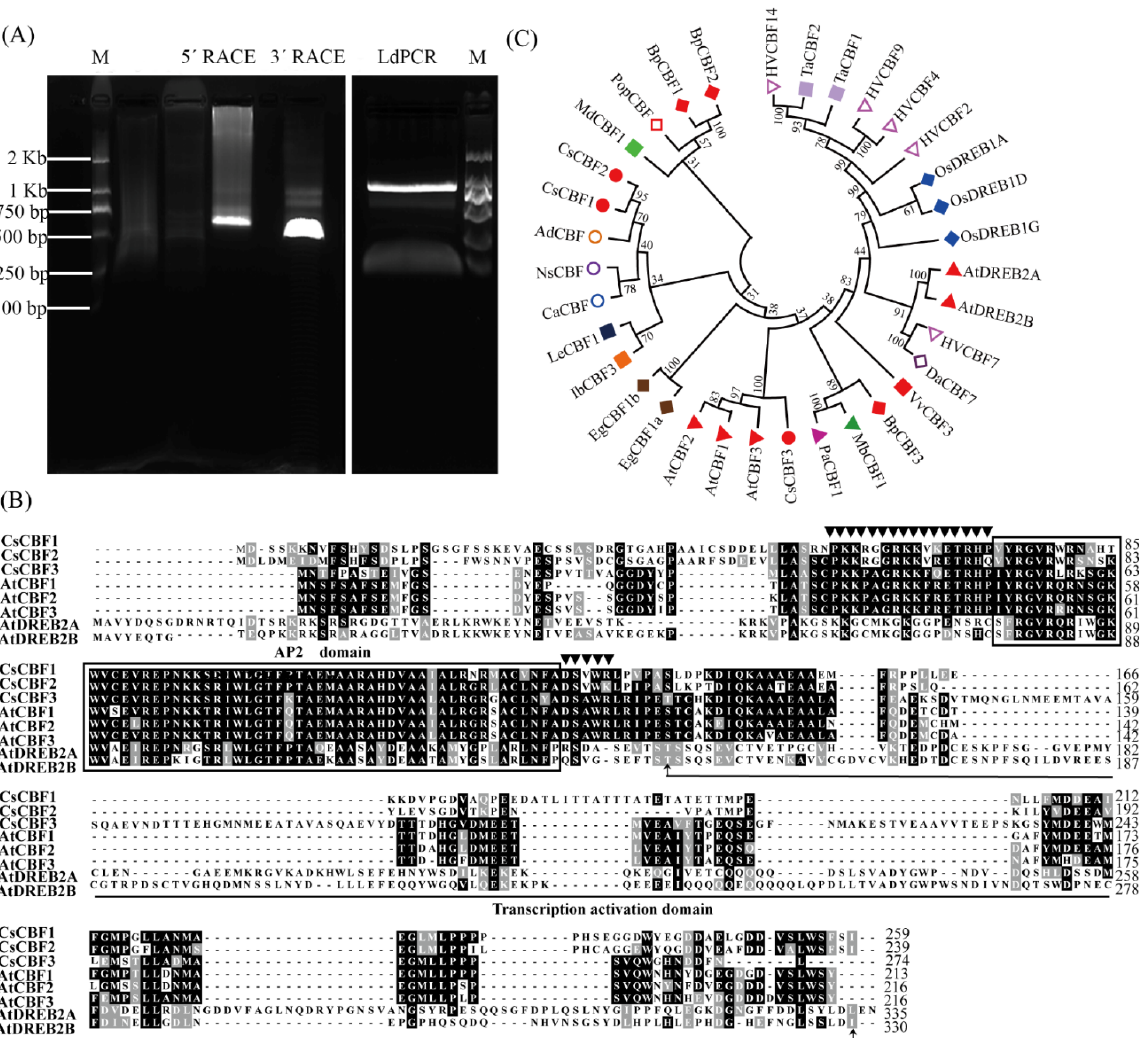
Figure 1. RACE clone, sequence alignment and phylogenetic analysis of CsCBF2. ( A ) Electrophore ‐ sis detection of RACE cloning product. M: DNA Marker; 5 ′ RACE: 5 ′ RACE cloning product of detection of RACE cloning product. M: DNA Marker; 5 (cid:48) RACE: 5 (cid:48) RACE cloning product of CsCBF2 gene; 3 ′ RACE: 3 ′ RACE cloning product of CsCBF2 gene; LdPCR: long distance PCR prod ‐ uct of CsCBF2 gene. ( B ) Sequence alignment of CsCBF2 with DREB proteins of Arabidopsis. The